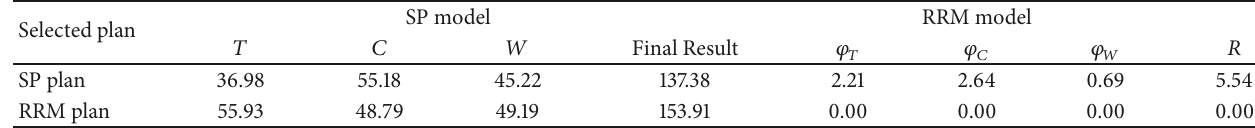
Table 8: The comparing